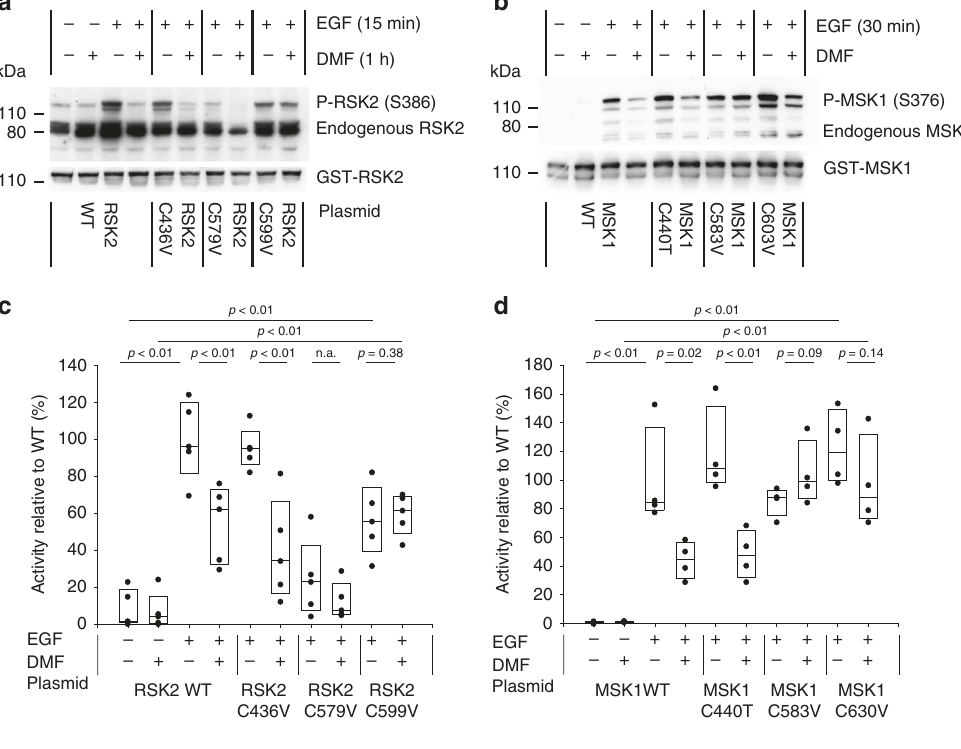
Fig. 4 Mutational studies of DMF inhibition in cells. Mutational analysis of HEK293 cells transfected with RSK2, MSK1, or cysteine mutants hereof. HEK293 cells were supplemented with DMF (140 μ M) and stimulated with epidermal growth factor (EGF, 1 ng ml – 1 ). a , b Representative western blots from RSK2 and MSK1 mutational analysis respectively. c , d RSK2 CTKD and MSK1 CTKD activity determined as the autophosphorylation of S386 and S376, respectively, relative to WT. The activity of EGF-induced wild-type was set to 100% ( n = 5 and n = 4, respectively; all data points indicated by black, fi lled